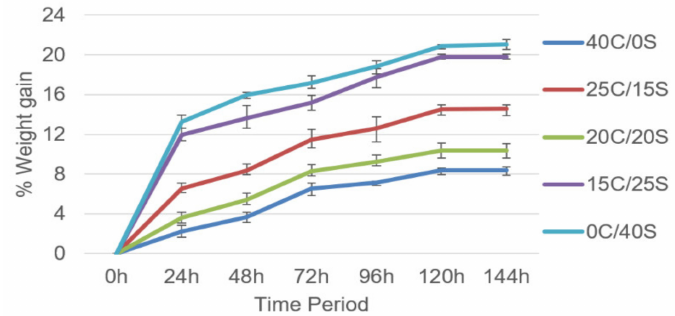
Figure 11. Weight gain in % by the composites vs. time period.